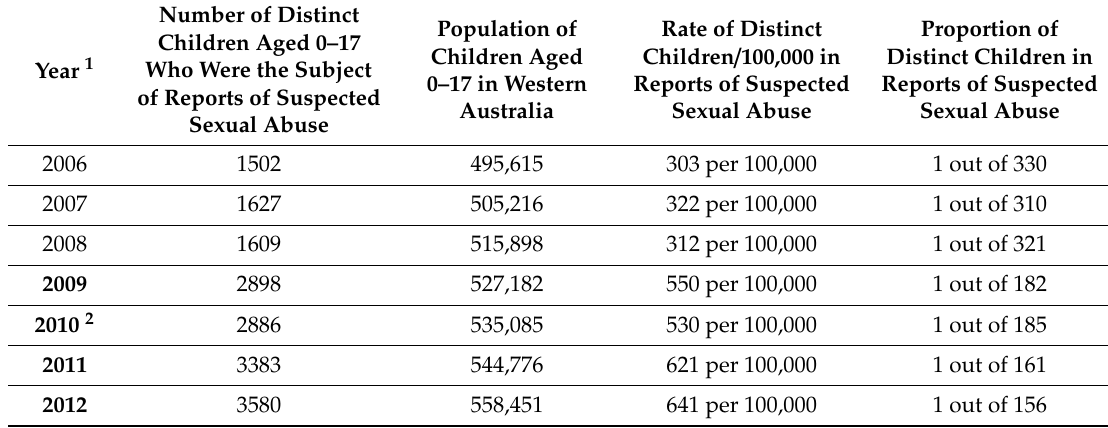
Table 1. Number and rate of children in reports of child sexual abuse: Western Australia